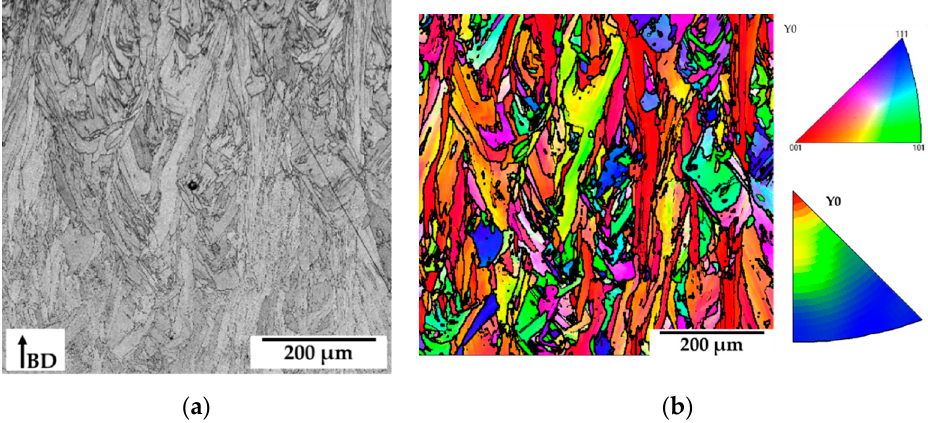
Figure 2. ( a ) Scanning electron microscope (SEM) micrograph showing the unetched microstructure of the SLM-manufactured Alloy 718 cross section parallel to the building direction (BD). ( b ) Electron back scatter diffraction (EBSD) inverse pole figure (IPF) colored and grain boundary map of the same image as ( a ). The color key representing the crystal orientation is given in the upper right corner and IPF in the lower right corner of the image ( b ).